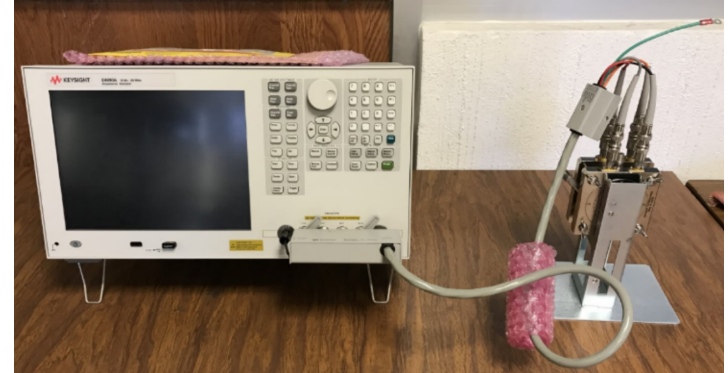
Figure 6. Experimental array for measurements of electrical impedance of commercial drugs. Impedance analyser and Liquid Test Fixture schematic.